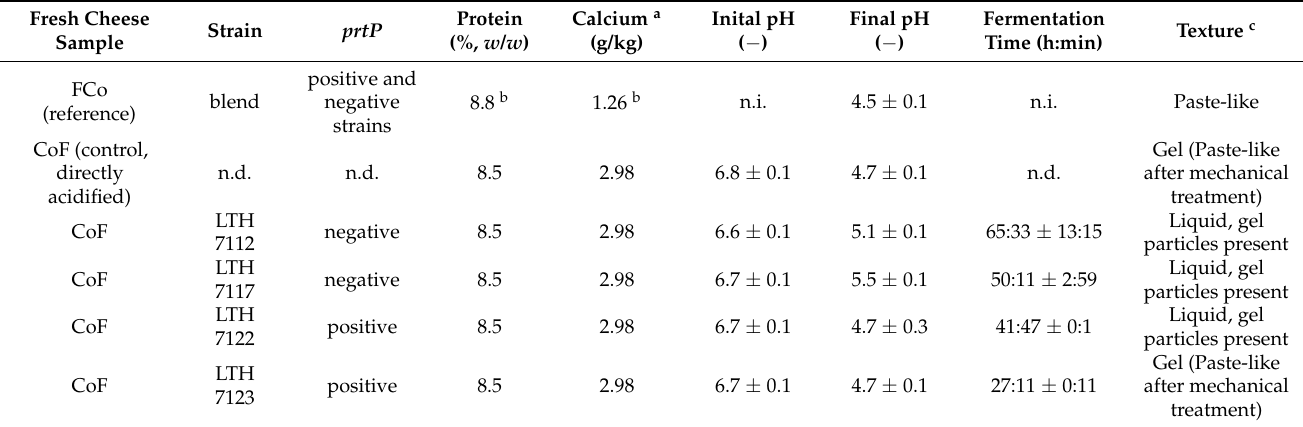
Table 2. Chemical composition and fermentation characteristics of (reference) fermented-concentrated and concentrated- fermented fresh cheeses manufactured by means of fermentation and without fermentation (control, direct acidified). Values represent the means and standard deviations (i = 2, n =